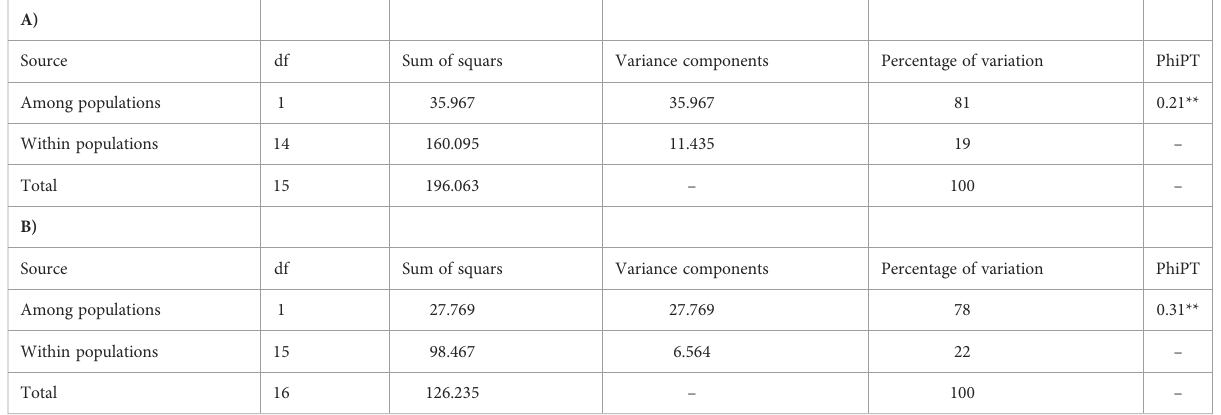
TABLE 3 Analysis of Molecular Variance (AMOVA) for A. retro fl exus (A) and C. album (B) populations.